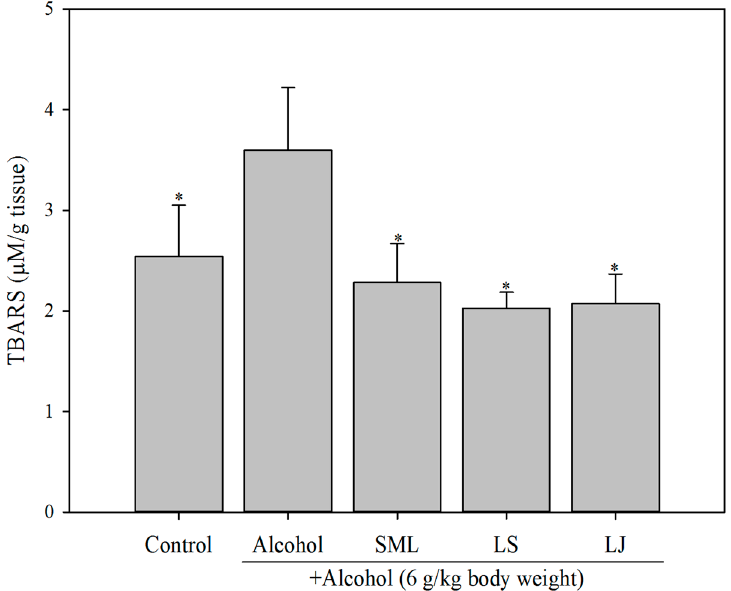
Figure 4. Effects of heat-killed Lactobacillus salivarius (LS), Lactobacillus johnsonii (LJ) and silymarin (SML) on malondialdehyde (MDA) levels in hepatic tissues of rats induced by alcohol. Experimental conditions were as described in the Materials and Methods. Bars represent mean ± SD ( n ≧ 9). * p < 0.05 for any alcohol treatment groups and control group versus alcohol group.